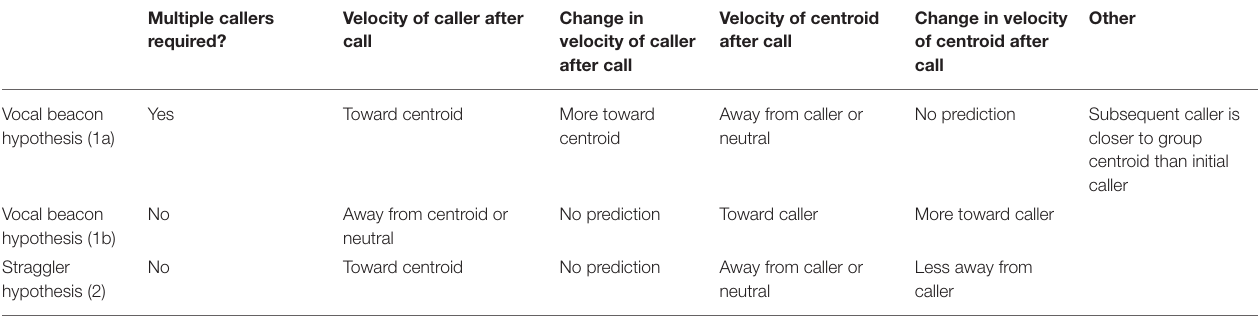
TABLE 1 | Our predictions regarding call production patterns and the velocities of the caller relative to the group centroid, and vice versa, surrounding call production. Multiple callers